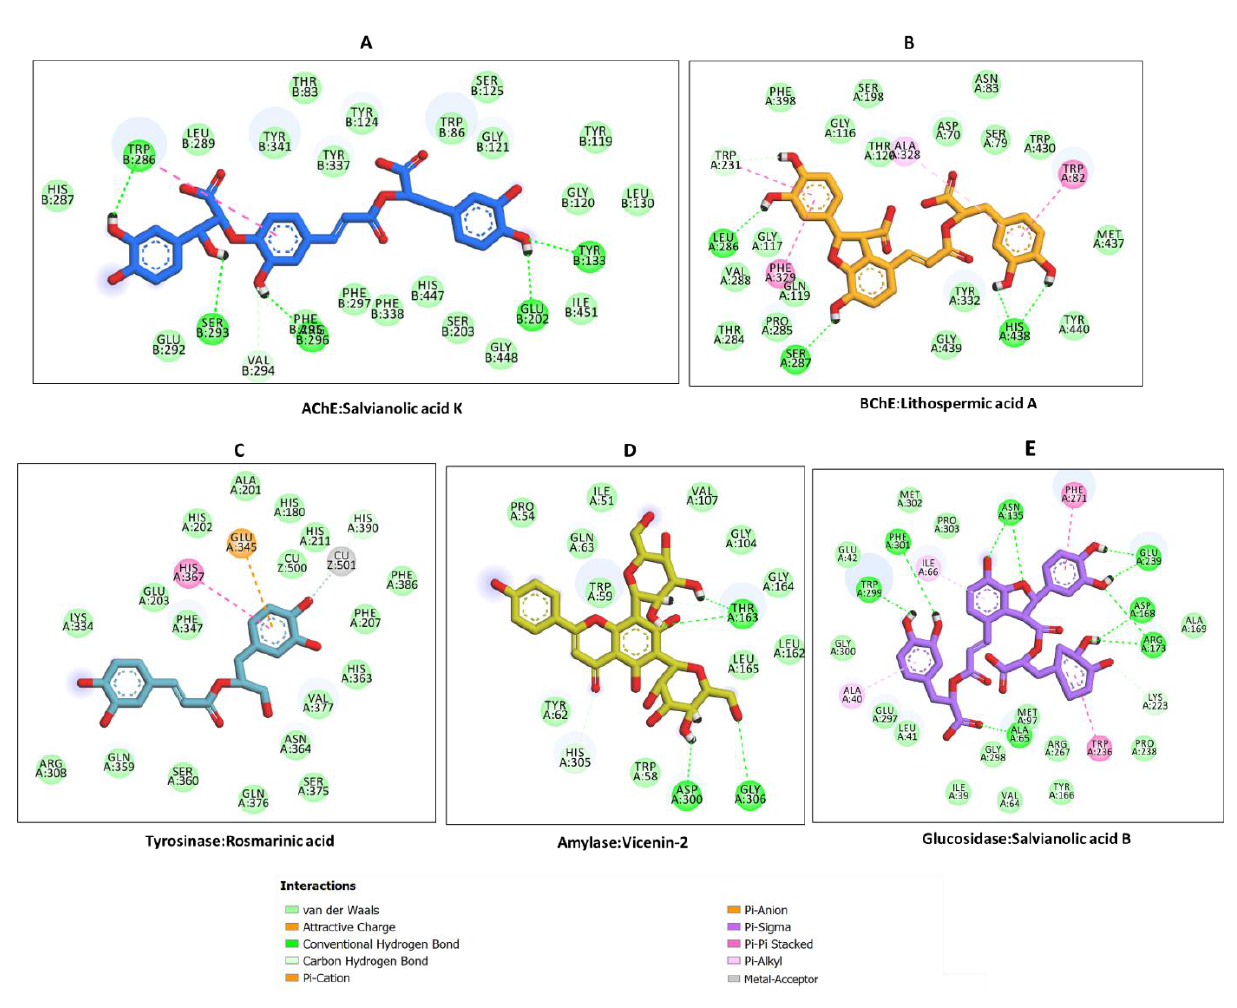
Figure 2. Protein – ligand interaction: ( A ) AChE and salvianolic acid K, ( B ) BChE and lithospermic acid A, ( C ) tyrosinase and rosmarinic acid, ( D ) amylase and vicenin-2, and ( E ) glucosidase and salvianolic acid B. The bioactive compounds were extracted from Thymbra capitata and Thymus sipyleus subsp. rosulans